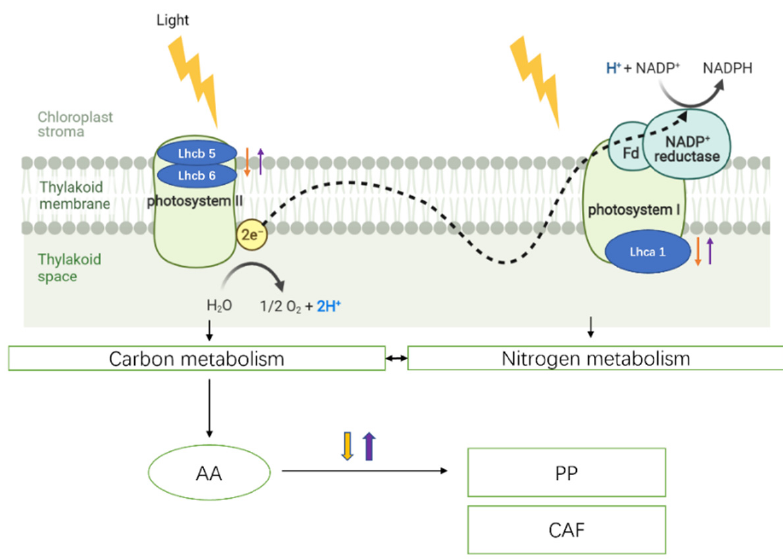
Figure 8. Function and location of Lhc proteins in PS I and PS II. Yellow arrows represent decreasing content in white-yellow tea cultivars, and purple arrows represent increasing content in purple-red cultivars. Drawn by Biorender (version 2022, Shiz Aoki, Toronto, ON, Canada). Unlike white-yellow cultivars, purple-red plants had a higher expression of Lhc